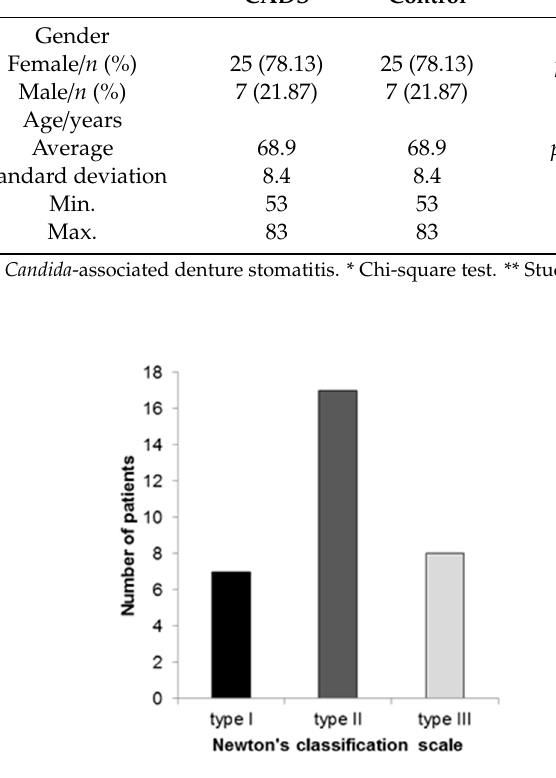
Figure 1. Severity of denture stomatitis in patients with Candida -associated denture stomatitis.